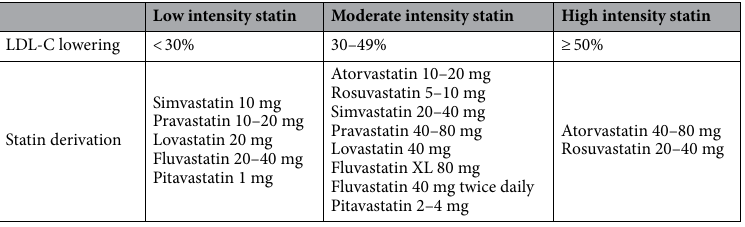
Table 1. Definition of low-, moderate-, and high-intensity statin therapy and anticipated LDL-C reduction according to the 2017 American College of Cardiology/American Heart Association